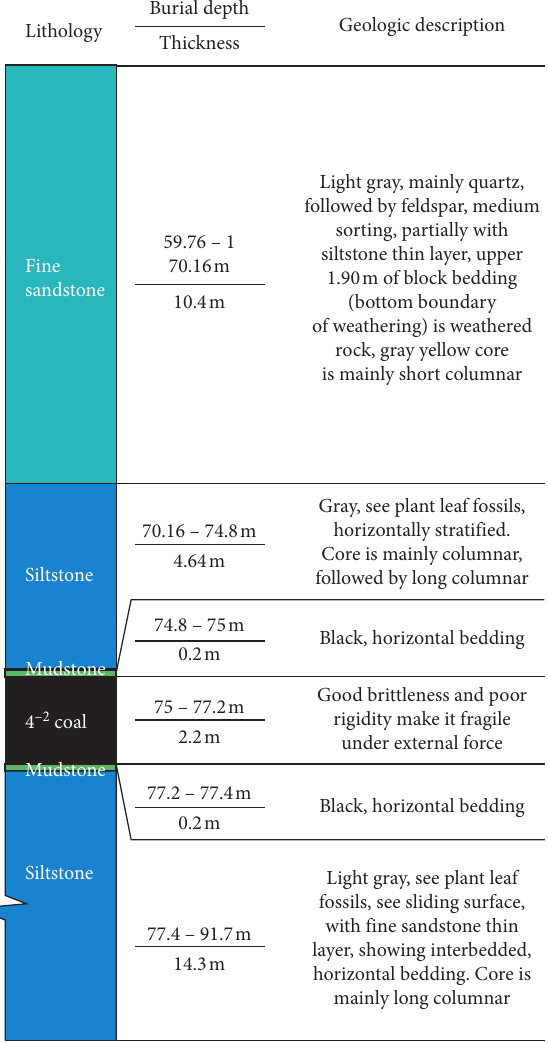
Figure 2: Stratigraphic column and geological descriptions of the rocks surrounding the 4-2 coal